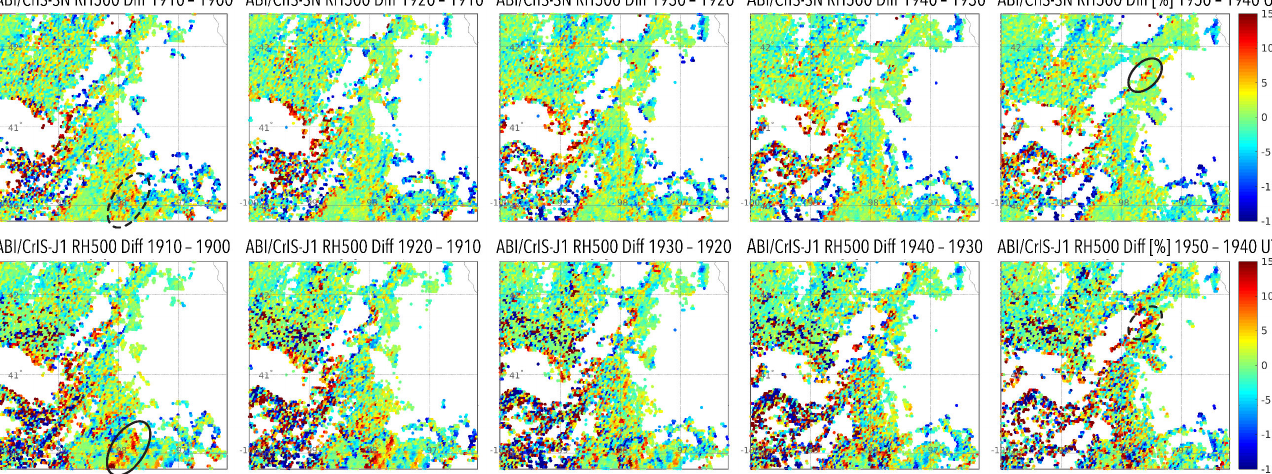
Figure 4. Top : 10 min time differences in ABI/CrIS-SN fusion results of RH [%] at 500 hPa from 1900 to 1950 UTC over Nebraska, starting at the SNPP overpass time at 1900 UTC; bottom : 10 min time differences in ABI/CrIS-J1 fusion results of RH [%] at 500 hPa from 1900 to 1950 UTC over Nebraska, starting at the JPSS-1 overpass time at 1950 UTC. Examples of moisture changes that correctly reshape into the other instrument’s results are marked by ovals (dashed and solid lines refer to initial and created features, respectively).